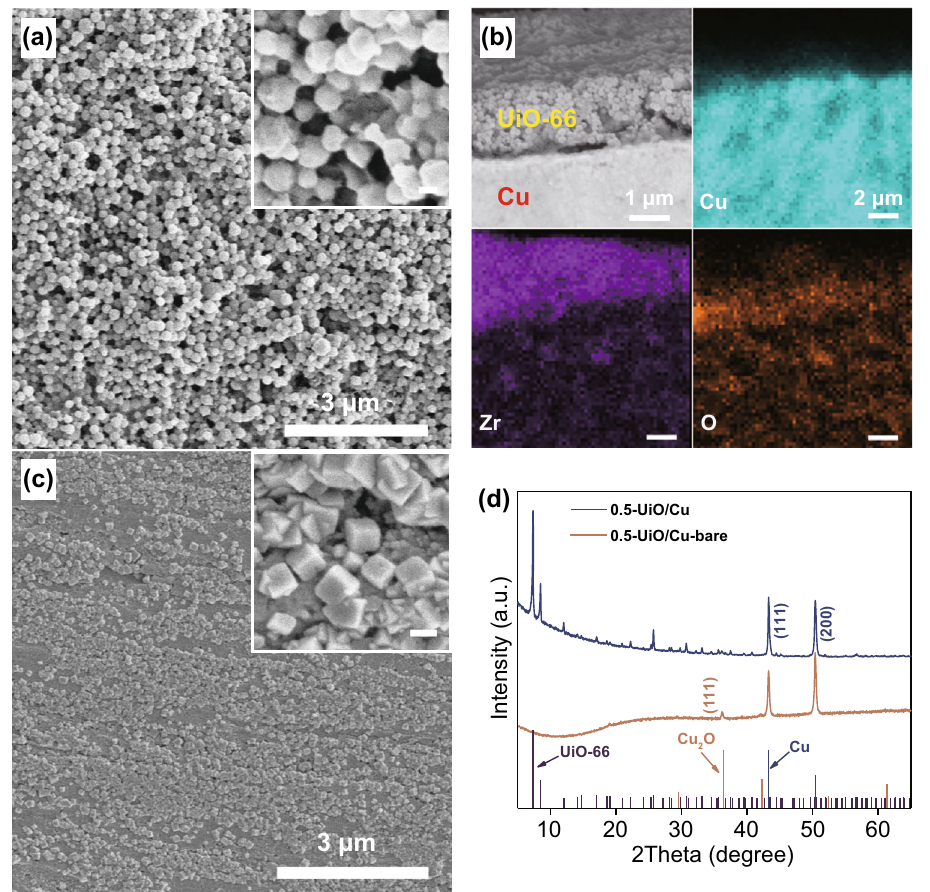
Fig. 1 a SEM images of 0.5-UiO/Cu (inset: high magnification SEM, the scale bar is 100 nm). b Cross-section SEM and EDS elemental map- pings of 0.5-UiO/Cu. c SEM images of 0.5-UiO/Cu-bare (inset: high magnification SEM, the scale bar is 100 nm) and d XRD patterns of 0.5- UiO/Cu and 0.5-UiO/Cu-bare. All samples in Fig. 1 are characterized before CO 2